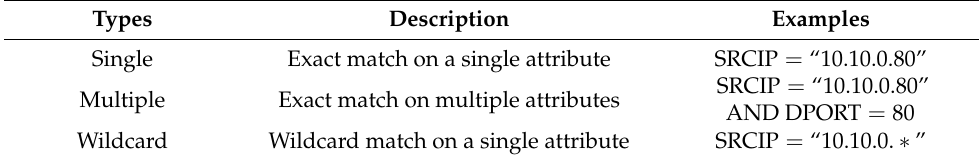
Table 3. Example of three types of queries.